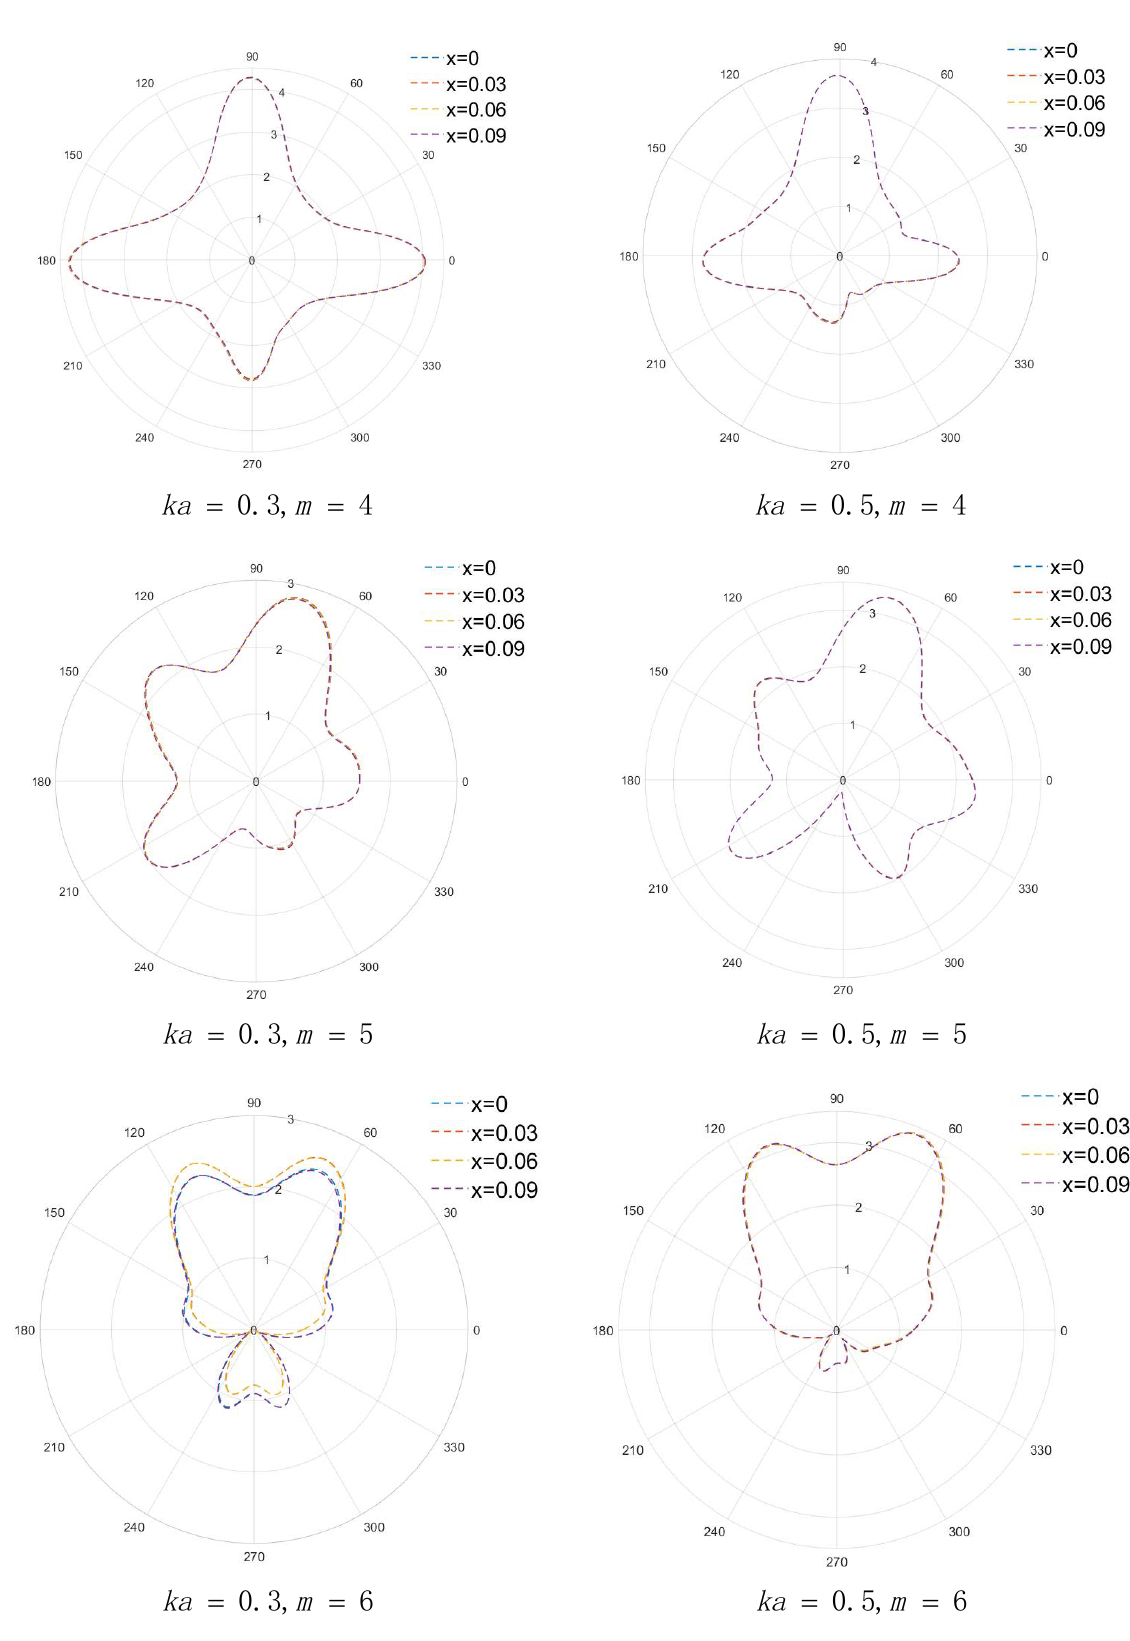
Figure 4. Polar plot of stress concentration around the hole.